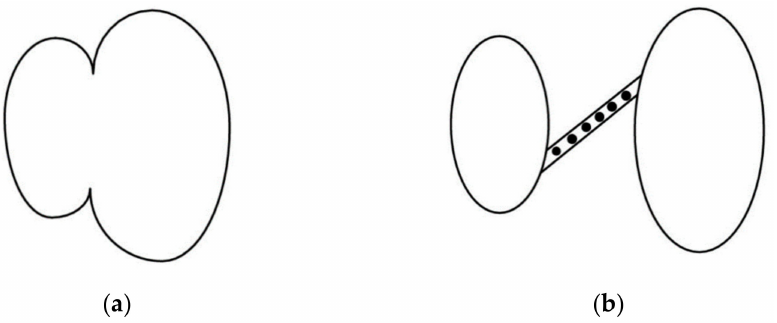
Figure 7. Mechanisms of cavity coalescence: ( a ) internal necking of ligaments between voids; ( b ) nucleation of secondary voids in shear bands